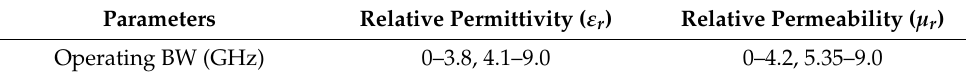
Table 4. The MTM structure’s